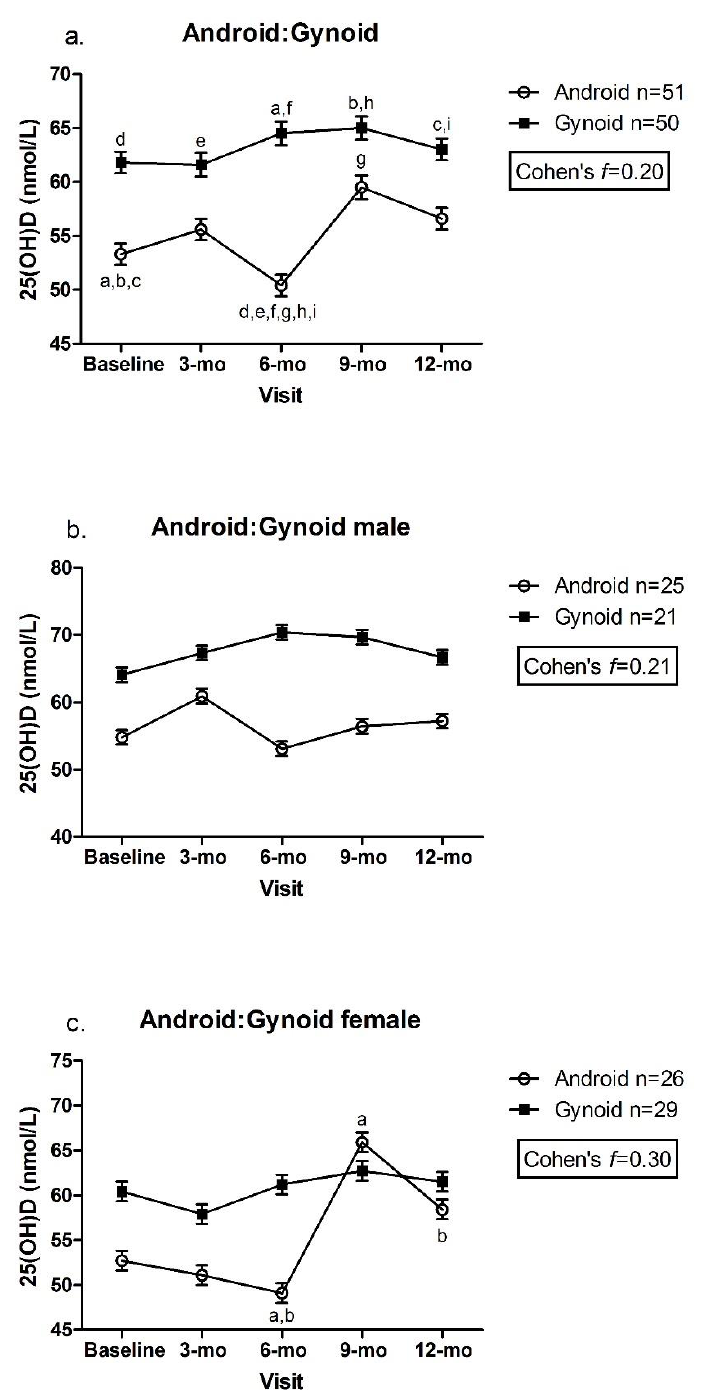
Figure 3. ( a ). Android:Gynoid; ( b ). Android:Gynoid male; ( c ). Android:Gynoid female. Plasma 25(OH)D across android:gynoid fat patterning by visit. Mixed effects model, mean ± SEM. Covariates include UVB exposure period, constitutive skin color, sunscreen use, dietary vitamin D intake. Values with same superscripts are significantly different from each other; p < 0.05, n = 101. Effect size reported as Cohen’s f .